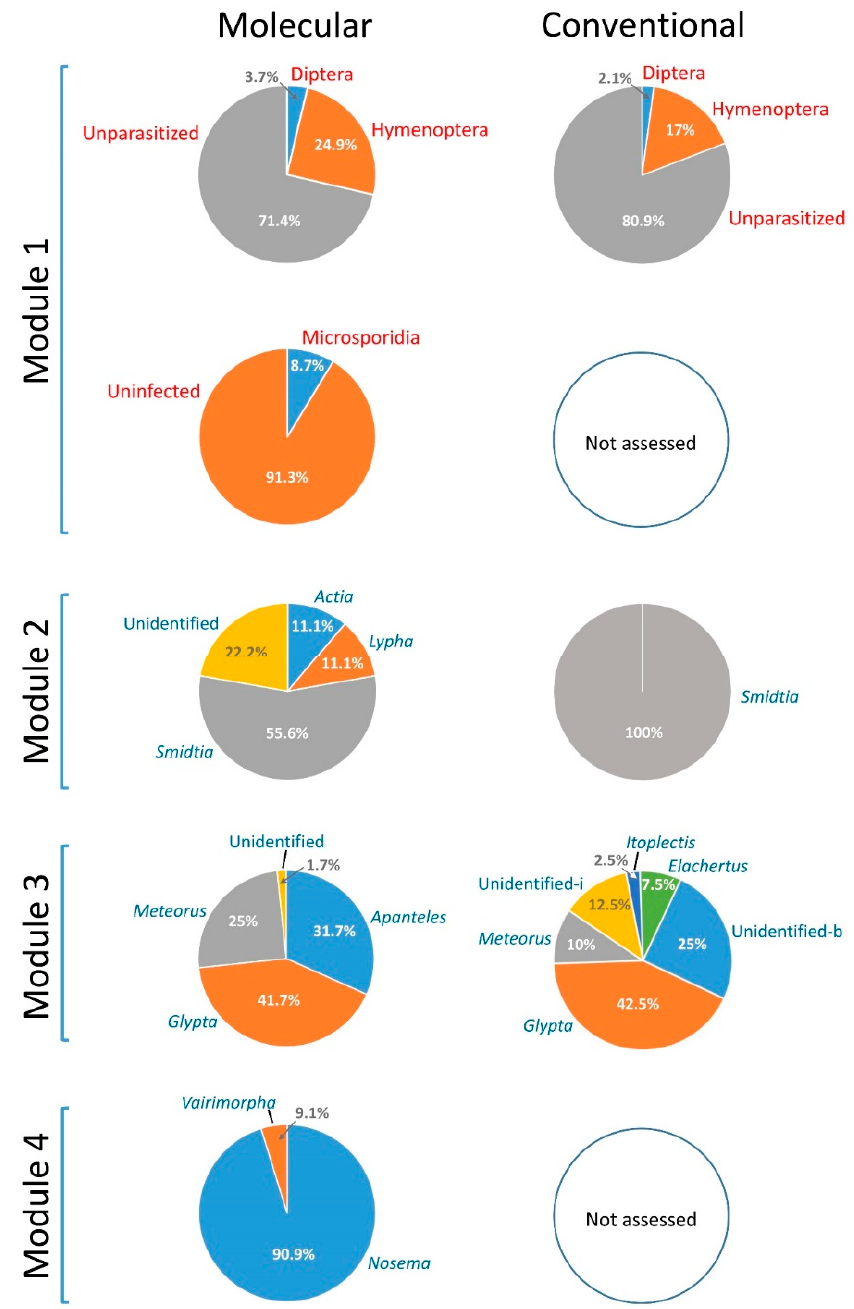
Figure 4. Results obtained for the detection and identification of spruce budworm natural enemies, comparing the molecular sorting tool with the conventional method, through the processing of two independent sets of samples collected in a fir stand located in the Charlevoix region of Quebec, in 2019. Inasmuch as they are independent, the two sets of samples were not expected to yield identical results, but to generate similar outcomes as they were from the same site/population. Two field collections were conducted during the L3/L4 and L6 stadia, resulting in two instar-specific datasets. Here, to simplify illustration of this comparative analysis, we combined the two instar-specific datasets; instar-specific results may be found in File S6. Please note that microscopic analysis of samples for microsporidian detection was not conducted in 2019. Sample sizes: Module 1, N = 241 (molecular), N = 235 (conventional); Module 2, N = 8 (molecular), N = 5 (conventional); Module 3, N = 55 (molecular), N = 40 (conventional); Module 4, N = 21 (molecular). “Unidentified-i”: unidentified ichneumonid; “Unidentified-b”: unidentified braconid. Only genus names are shown for identifications by Modules 2, 3, and 4; full species names are provided in Table 2 (note that all Apanteles specimens identified by Module 3 were A. fumiferanae